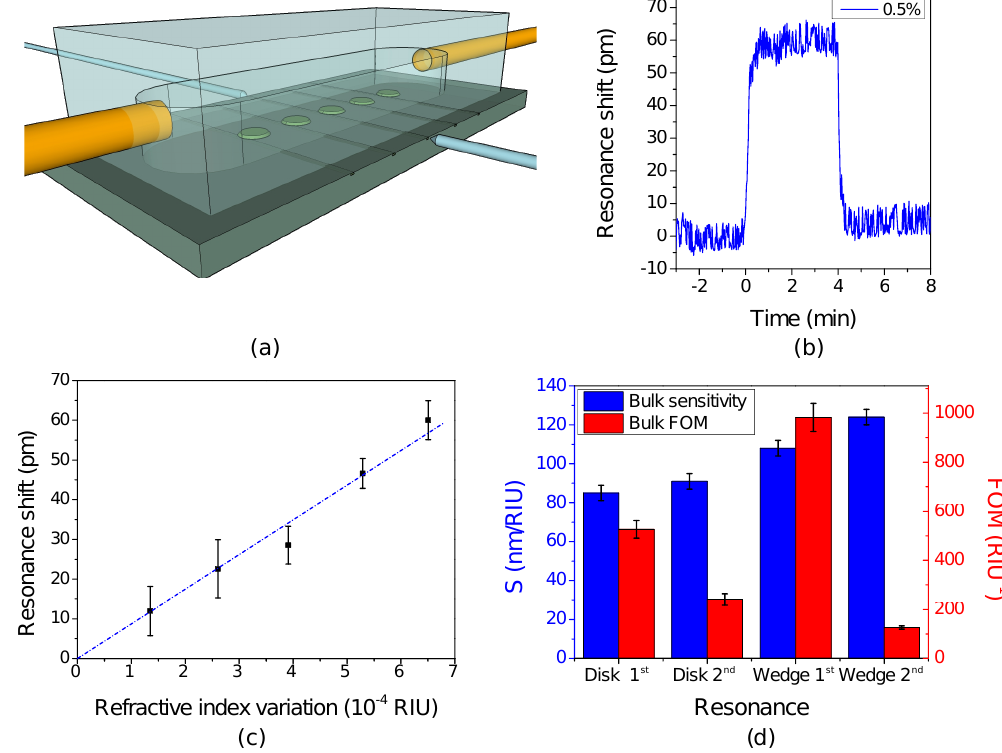
Figure 2. ( a ) 3D model of the experimental apparatus. The waveguides on the photonic chip are accessed with lens-tapered optical fibers. A PDMS flow cell is fixed above the sensor surface, and the liquid is delivered via quartz capillaries; ( b ) Resonance shift temporal evolution during the injection of a small volume of glucose-water solution (concentration 0.5% wt/wt, refractive index variation 6 . 5 × 10 − 4 RIU, refractive index unit). The probed